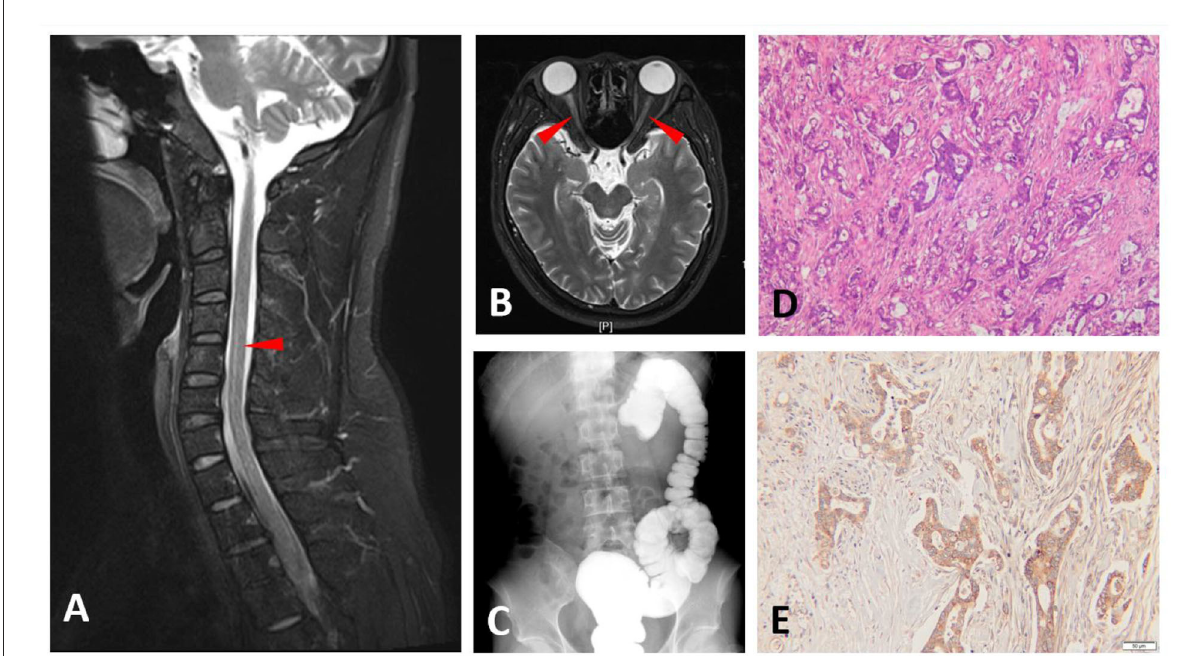
FIGURE3 Magnetic resonance imaging (MRI), barium enema, and pathological findings of Case 3. T2-weighted MRIs show abnormal signals in the cervical spinal cord (A) and T2-weighted fat-suppressed MRI displayed hyperintensity in bilateral optic nerves (B) (arrowhead). Barium enema shows truncation of the transverse colon (C) . Hematoxylin and eosin (H&E) staining of the transverse colon tumor section (D) . Aquaporin-4 (AQP-4)-specific monoclonal antibody staining of the transverse colon tumor section shows intense immunoreactivity (E) .